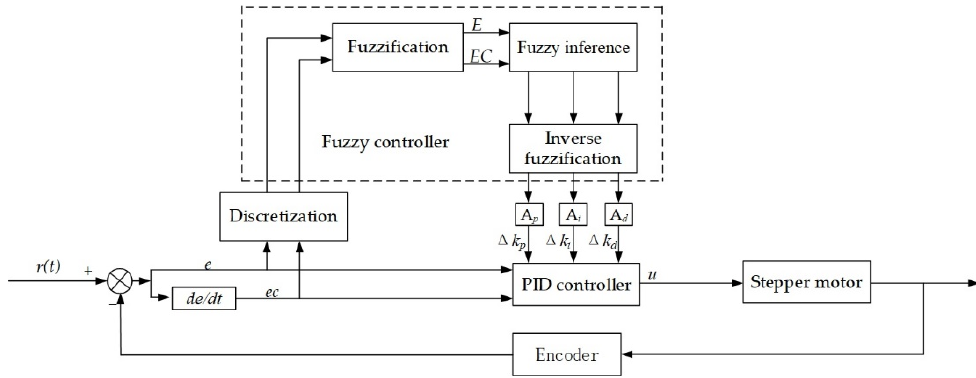
Figure 2. Block diagram of the fuzzy PID control